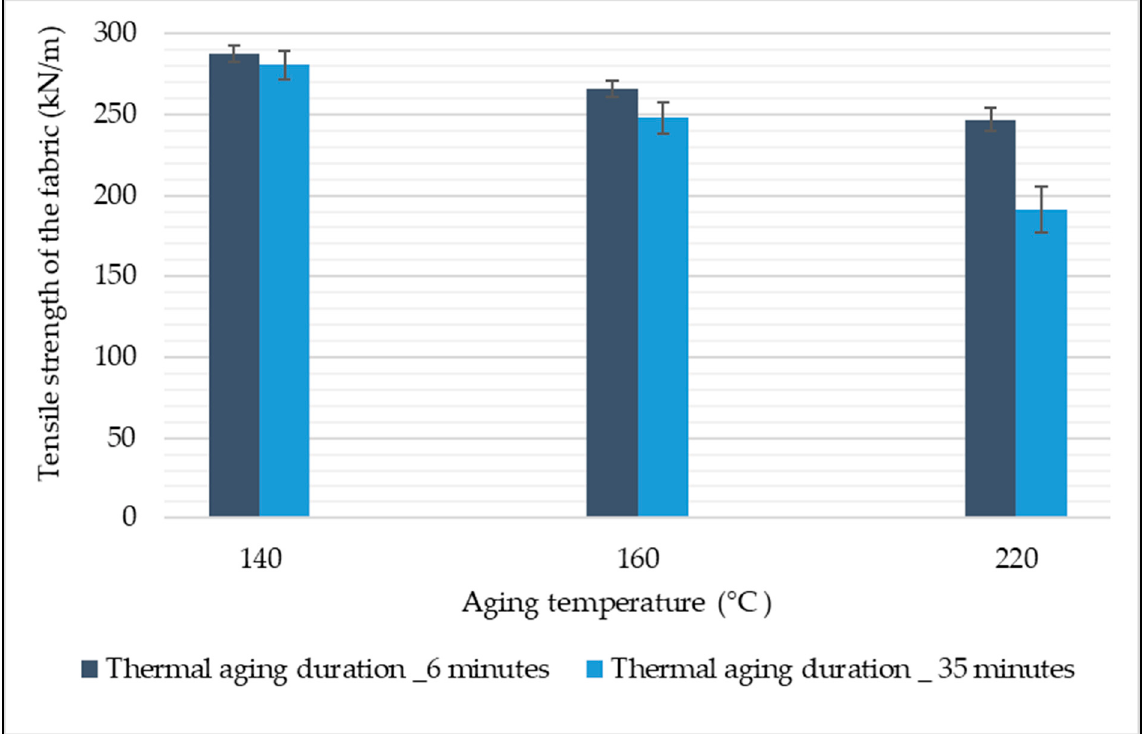
Figure 9. Effect of thermal aging on the tensile strength of RFL ‐ dipped EP woven fabric.